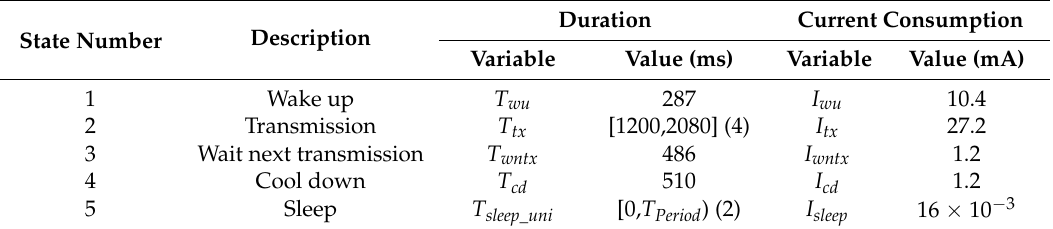
Table 2. States, variables and measurement results for Sigfox unidirectional transactions. For a bit rate of 100 bit/s, T tx can take values between 1200 ms (1-byte payload) and 2080 ms (12-byte